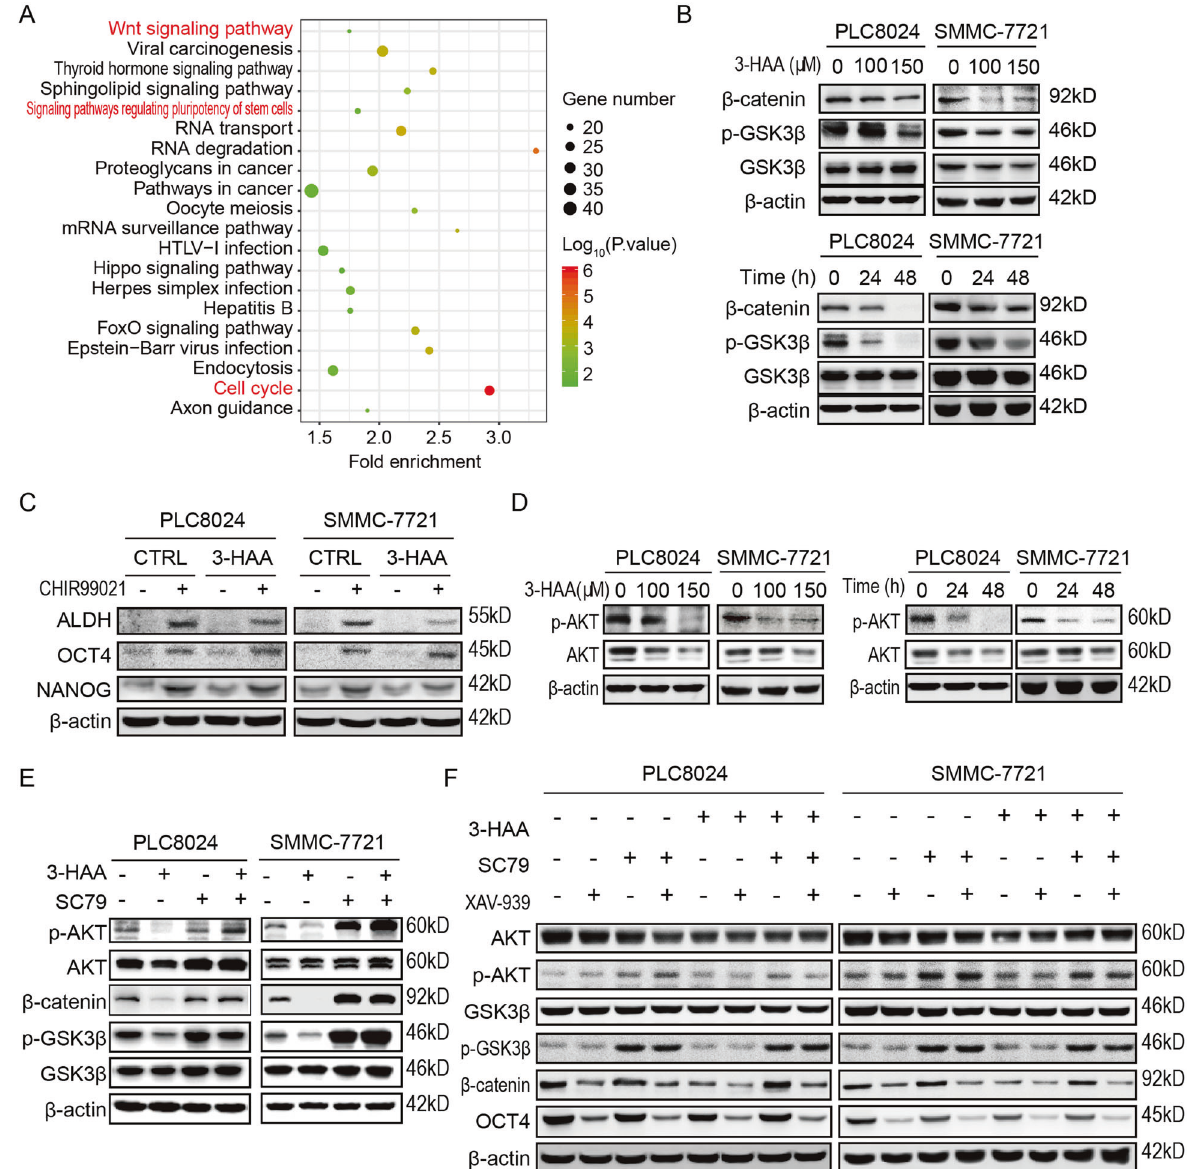
Fig. 4 3-HAA suppressed Wnt signaling by decreasing AKT activity. A The KEGG analysis on the upregulated/downregulated genes. The genes whose expression changed more than 2 folds in 3-HAA-treated HCC cells were analyzed. B 3-HAA inhibited GSK3 β / β -catenin signaling in SMMC-7721 and PLC8024 cells. The treating time for the dose course experiment was 24 h. The 3-HAA dose for the time course analysis was 100 μ M. C The Wnt activator CHIR99021 abolished 3-HAA inhibition on the expression of stem cell markers ALDH, OCT4, and NANOG. The dose of CHIR99021 and 3-HAA was 5 and 100 μ M, respectively. Cells were treated for 24 h. D AKT phosphorylation detection in 3-HAA-treated SMMC7721 and PLC8024 cells. The treating time and the 3-HAA dose were the same as above. E SC79 recovered 3-HAA ’ s inhibition on AKT phosphorylation and GSK3 β / β -catenin signaling. The dose of SC79 and 3-HAA were 15 and 100 μ M, respectively. Cells were treated for 24 h. F CHIR99021 abolished 3-HAA inhibition on AKT phosphorylation and GSK3 β / β -catenin signaling. The dose of CHIR99021 and 3-HAA was 5 and 100 μ M, respectively. Cells were treated for 24 CD133 + CD44 + tumor cells than either sorafenib alone or 3-HAA alone. However, additional CHIR99021 recovered the proportion of CD133 + CD44 + subpopulation in xenografts (Figs. 5F and S5C). The immunohistochemistry staining demonstrated that the combined treatment inhibited AKT/Wnt/ β -catenin signal and reduced the tumor stemness in HCC xenografts, while the Wnt activator CHIR99021 restored the Wnt/ β -catenin signal and tumor stemness (Fig. 5G), suggesting that the AKT/GSK3 β / β -catenin signaling was critical for the synergistic effect of the combination treatment on HCC cells.